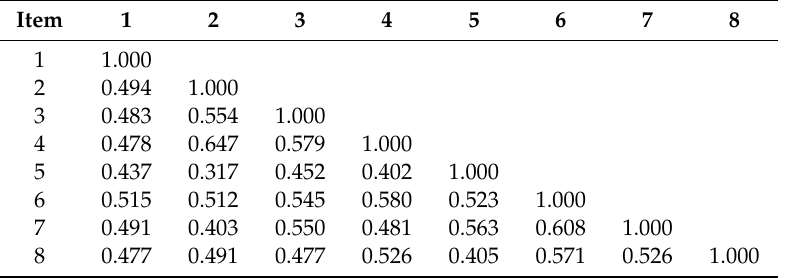
Table 3. Polychoric correlation coe ffi cients between GSES scale items in the whole